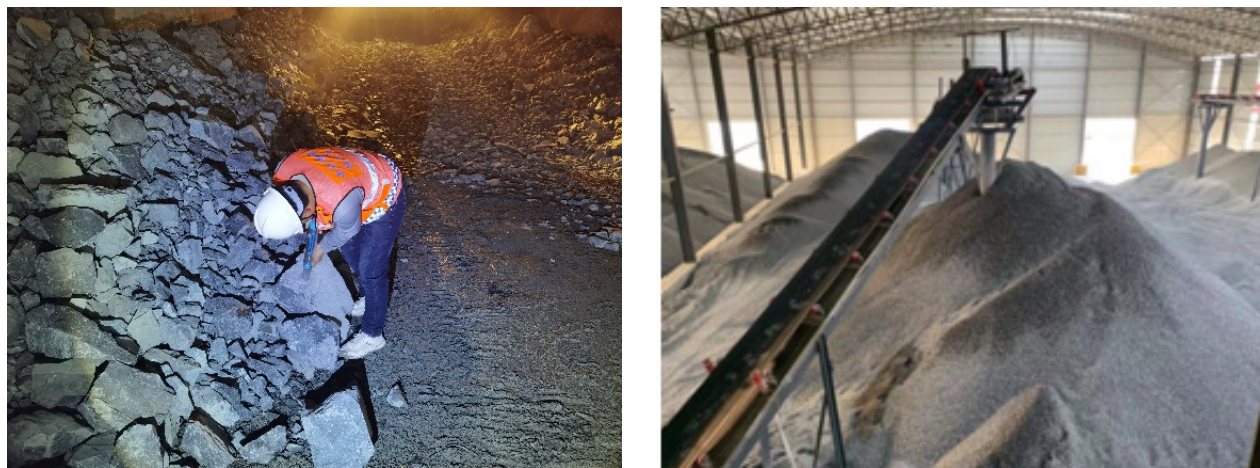
Figure 1. Tunnel slag and machine-made sand.